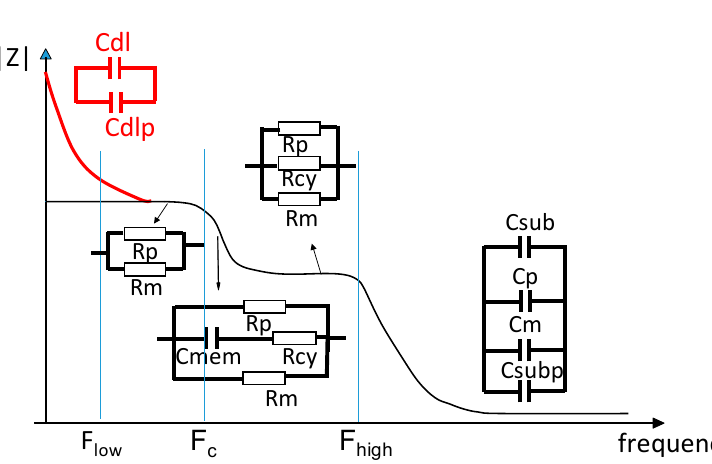
Figure 3. Representation of the impedance spectrum with electric models.